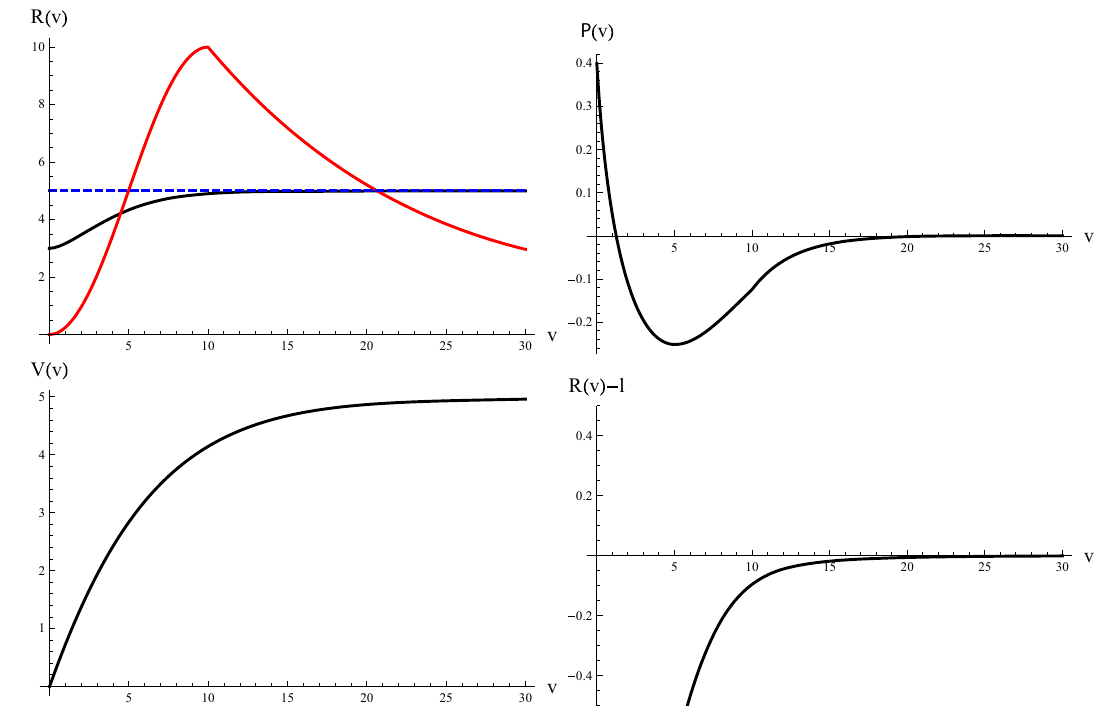
Fig. 1 Numerical solution for m 0 = 5, (cid:3) = 5, v 0 = 10, α = 50, R ( 0 ) = 3, R (cid:2) ( 0 ) = 0, and V ( 0 ) = 0. Upper left: the shell trajectory (black thick curve), where the red curve is the (putative) outer appar- ent horizon ( R = 2 m ) and the blue dashed curve is R = (cid:3) ; this outer apparent horizon is only meaningful if it is outside the shell. Upper